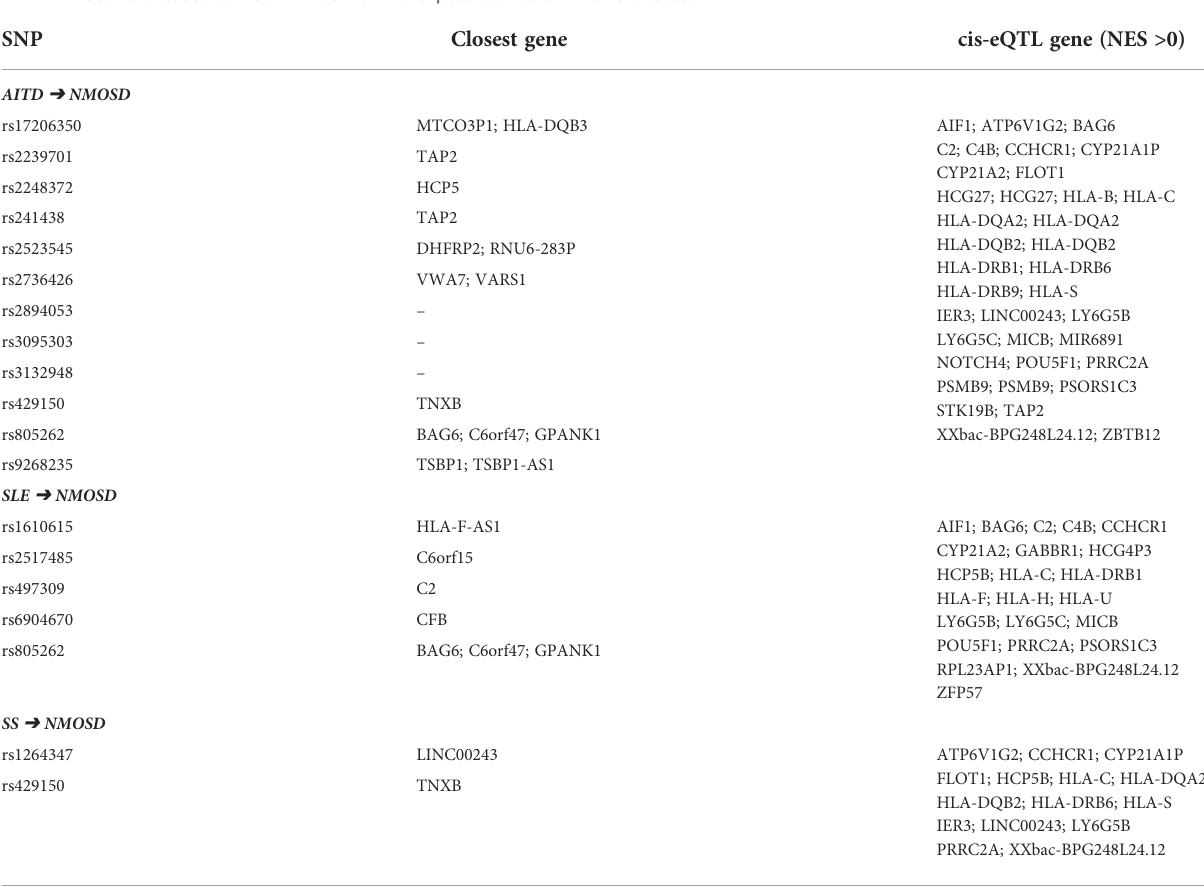
TABLE 4 eQTLs of causal SNPs of NMOSD on the exposure of autoimmune diseases.